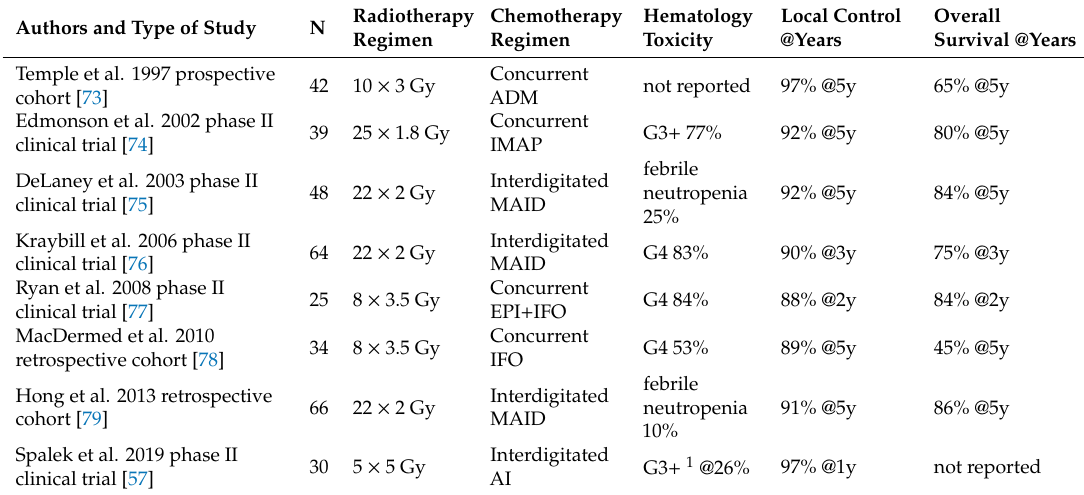
Table 3. Novel neoadjuvant radiochemotherapy regimens in soft tissue